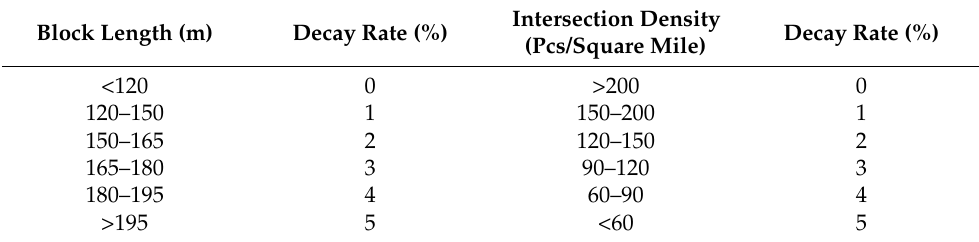
Table 2. Intersection density, block-scale attenuation